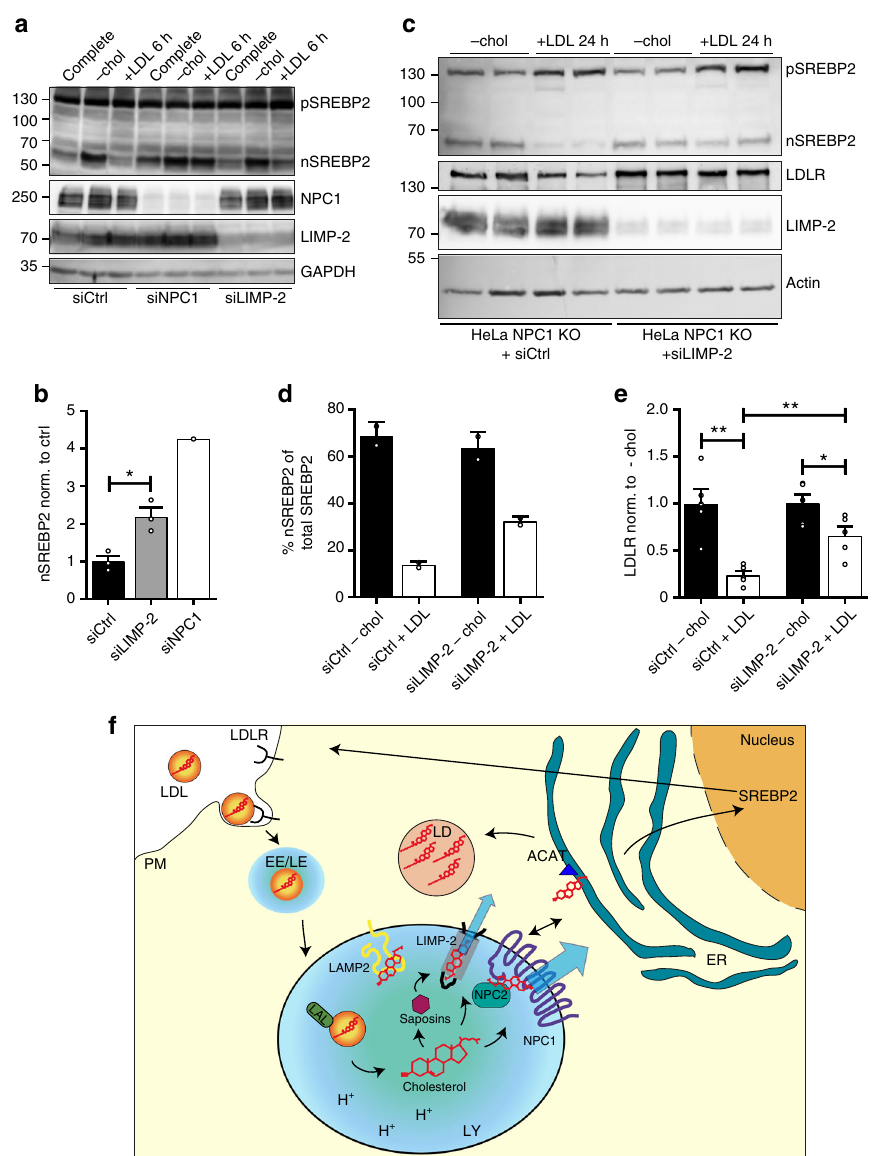
Fig. 4 Regulation of cholesterol homeostasis is altered in LIMP-2 de fi cient cells. Analysis of LIMP-2 in fl uence on transcriptional regulation of cholesterol homeostatic genes. a Termination of SREBP2 processing in response to abundant cholesterol in the ER (induced by LDL loading) is absent or incomplete in NPC1-silenced and LIMP-2-silenced HeLa cells, respectively. HeLa WT cells were treated with scrambled (ctrl), NPC1 or LIMP-2 siRNA, respectively, and incubated in either full medium, cholesterol-depleted medium or LDL-loaded medium. The processing of SREBP2 in response to high or low cholesterol levels was analyzed by immunoblot. b The quanti fi cation depicts the amount of nSREBP2 after LDL loading in cells treated with scrambled (ctrl), NPC1 or LIMP-2 siRNA, respectively ( n = 3; data (mean ± SEM) from two experiments; *P ≤ 0.05, t -test). c Analysis of the effect of cholesterol depletion and re- addition of LDL cholesterol for 24 h in NPC1-de fi cient HeLa cells on nSREBP2 formation. Cells were either treated with control siRNA or with LIMP-2 speci fi c siRNA. The processing of the SREBP2, as well as the expression of the LDL receptor (LDLR) and LIMP-2 was followed by immunoblot. Note that additional depletion of LIMP-2 led to incomplete termination of nSREBP2 fragment and LDLR formation after cholesterol loading for 24 h. d Quanti fi cation of nSREBP2 levels. Nuclear SREBP2 fragment as percentage of total SREBP2 is depicted. ( n = 2; data (mean ± SD) from one experiment). e Quanti fi cation of LDLR levels after cholesterol loading, normalized to the cholesterol-depleted samples ( n = 5; data (mean ± SEM) from two experiments; *P ≤ 0.05, **P ≤ 0.01, unpaired two-tailed Student ’ s t -test). f Model of the role of LIMP-2 in lysosomal cholesterol ef fl ux. Source data are provided as a Source Data fi Healthcare, 29-1487-21) in 50 mM Tris-HCl buffer, pH 7.0. SapA fractions were streptomycin for 4-6h and induced with 0.8mM IPTG overnight at 15°C and concentrated and stored. harvested by centrifugation. The pellet was re-suspended in binding buffer (25 mM NaCl, 25 mM Tris-HCl, pH 7.0), lysed by sonication, and centrifuged at 15,000 rpm for 30 min. Then, the supernatant was heated at 90 °C for 15min. After pelleting Microscale thermophoresis (MST) . MST experiments were performed on a down the precipitate by centrifugation at 15000rpm for 30min, the resulting Monolith NT.115 instrument (NanoTemper Technologies). Puri fi ed His-tagged supernatant was applied directly to a Q-anion-exchange column (GE Healthcare, LIMP-2 protein, labeled using the Monolith His-Tag Labeling Kit Red-tris-NTA 17115301) and the bound protein was eluted with a linear gradient of elution buffer (NanoTemper Technologies) and diluted in buffer with 0.1% Fos-Choline 13 (300 (1M NaCl, 25mM Tris-HCl, pH 7.0). The peak fractions containing sapA were mM NaAc pH 6.0, 150 mM NaCl, 0.05% Tween 20) to a concentration of 25 nM, collected and further puri fi ed by Superdex-75 size-exclusion column (GE